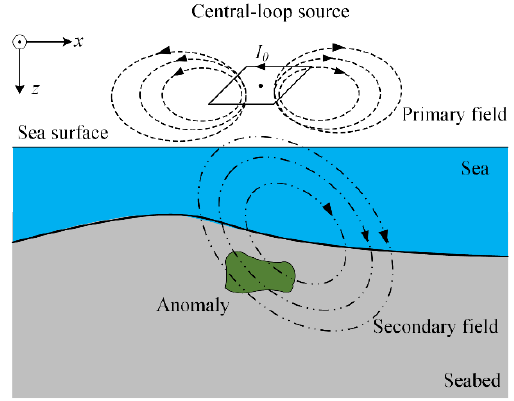
Figure 1. Schematic of airborne transient electromagnetic (TEM) system.